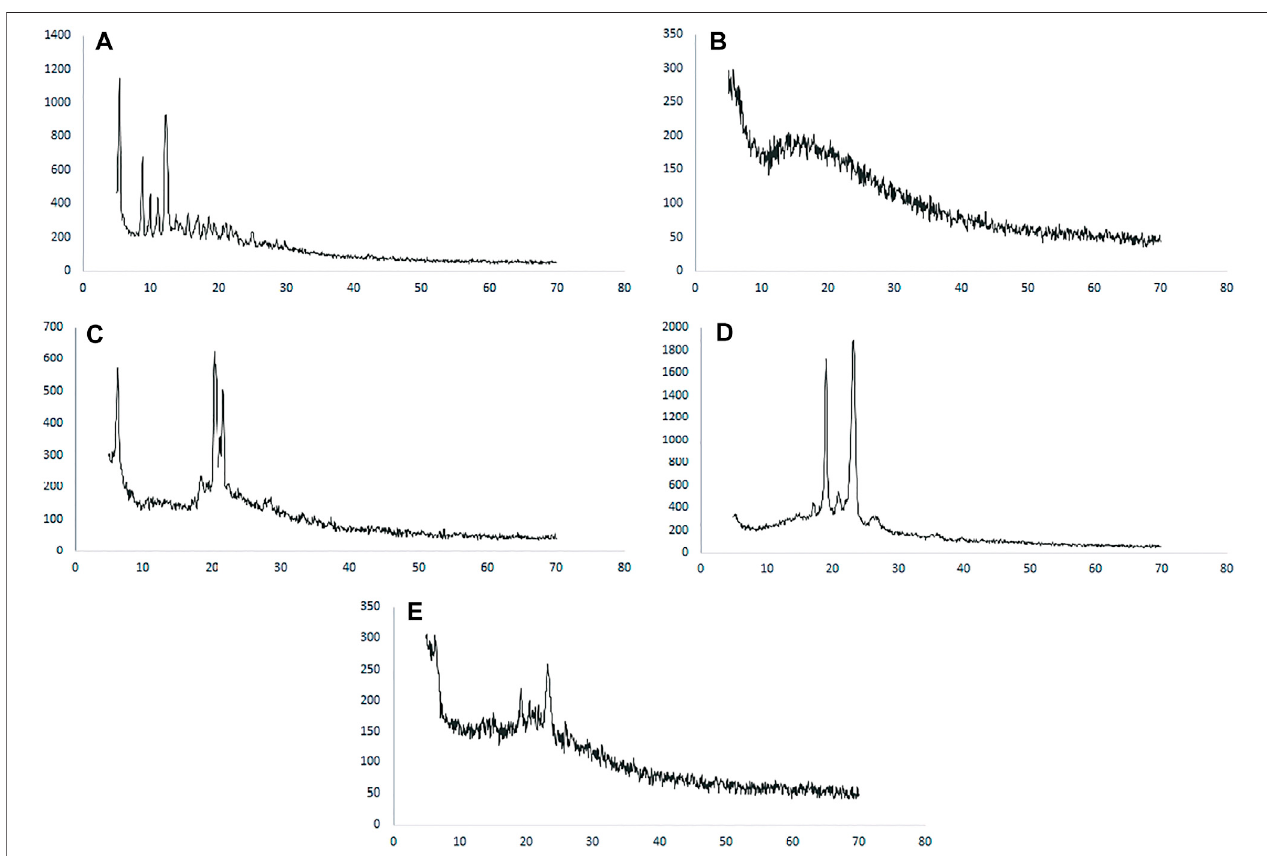
FIGURE 3 | XRD spectra of (A) paclitaxel, (B) PLGA, (C) SLS, (D) poloxamer 407, and (E) nanoformulation.